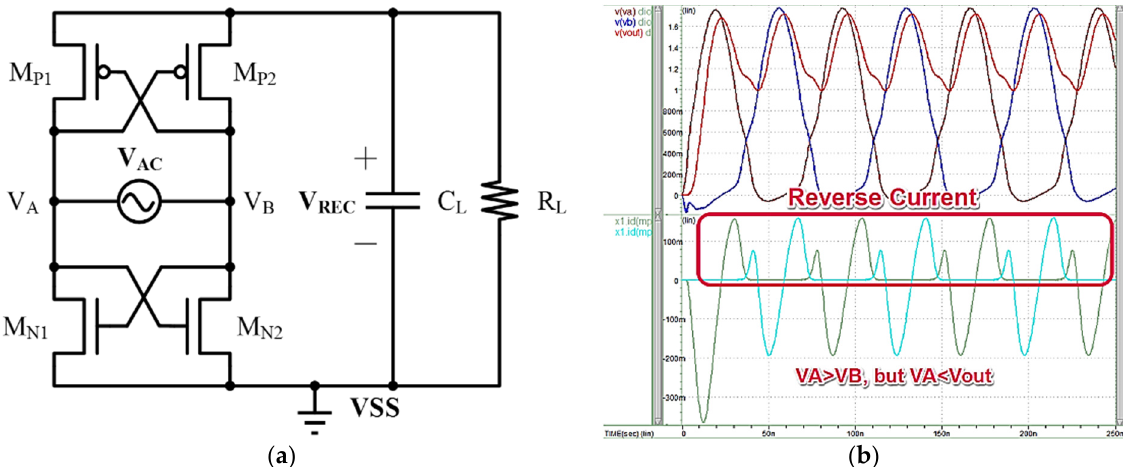
Figure 4. ( a ) Dual Cross-Coupled Rectifier Architecture. ( b ) Simulated Dual Cross-Coupled Rectifier (Vth ≈ 0.4 V).